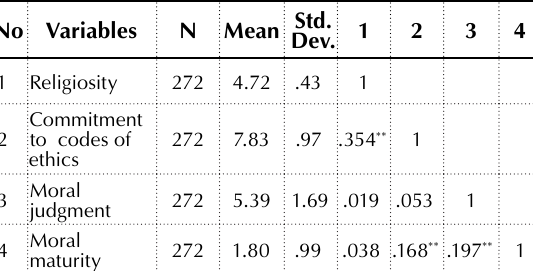
Table 1. Descriptive statistics and correlations